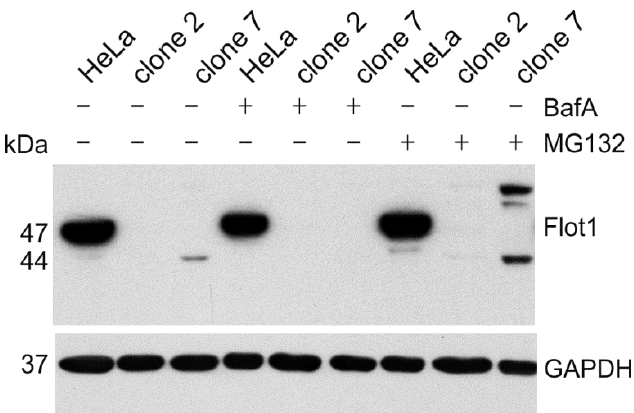
Figure 8. Western Blot analysis of cell lysates of clone 2 and clone 7. HeLa cells and clones 2 and 7 were treated for 24 h with 50 nM bafilomycin A (BafA) or 10 µM MG132 and blotted with anti-flotillin-1 antibody.